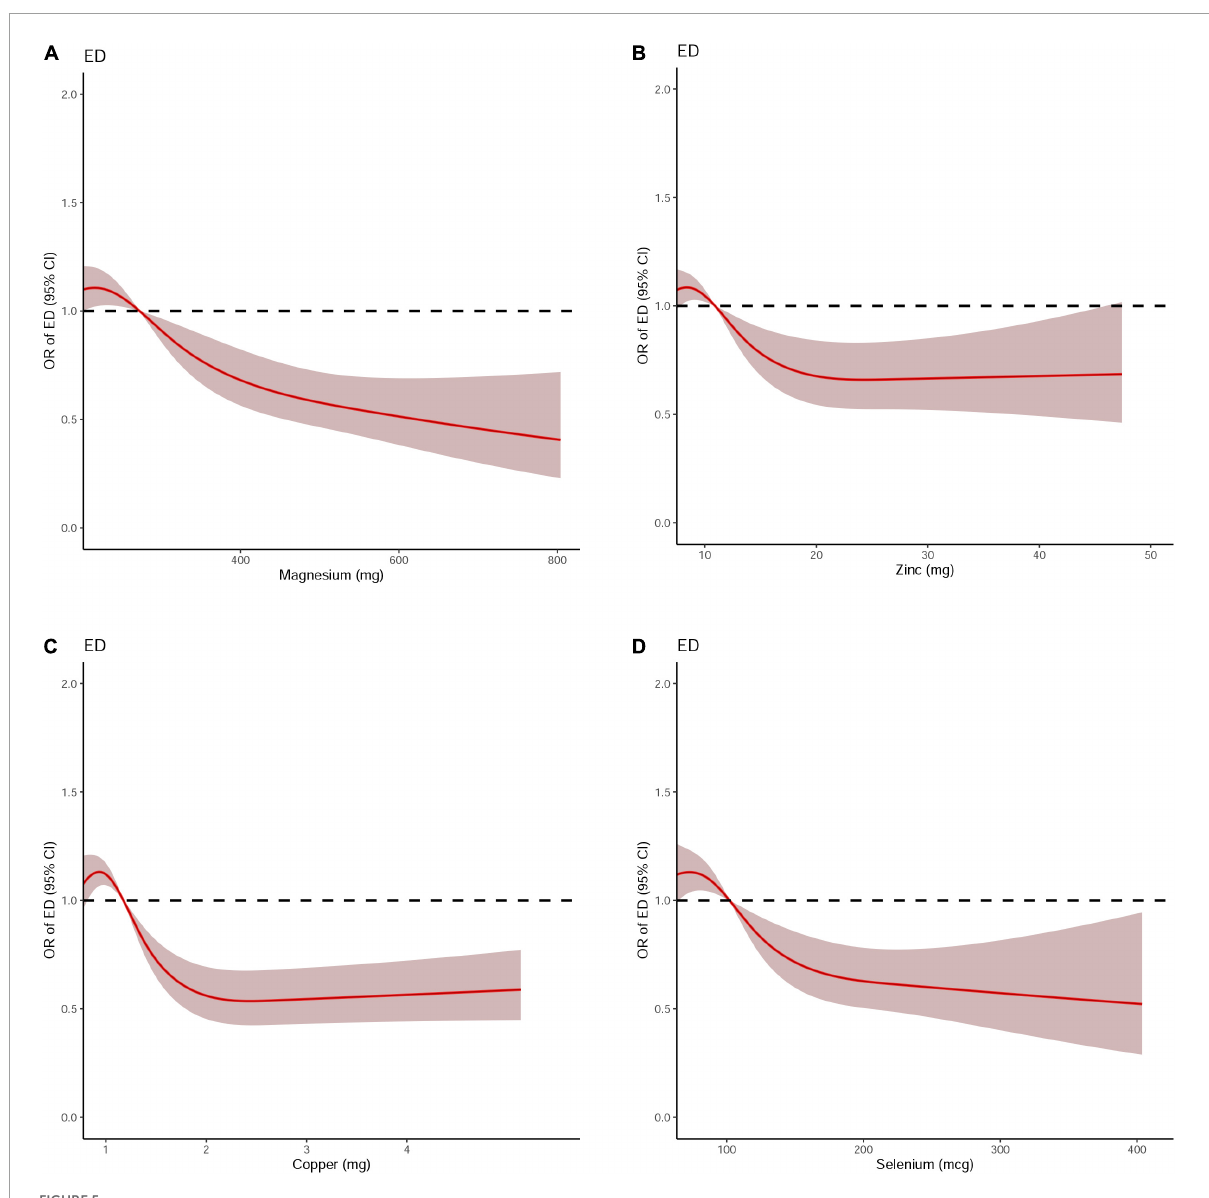
FIGURE5 The dose-response analysis of dietary metal intake and erectile dysfunction after propensity score matching. (A) Magnesium; (B) Zinc; (C) Copper; and (D)